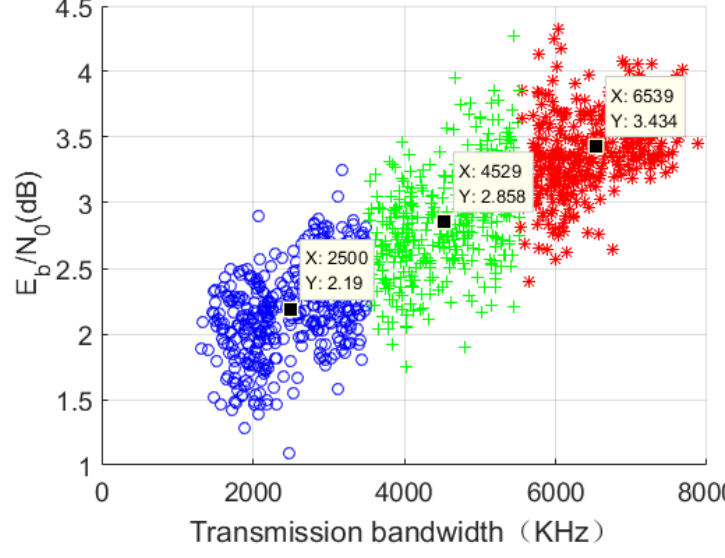
Figure 19. Clustering of simulated wireless channel conditions.